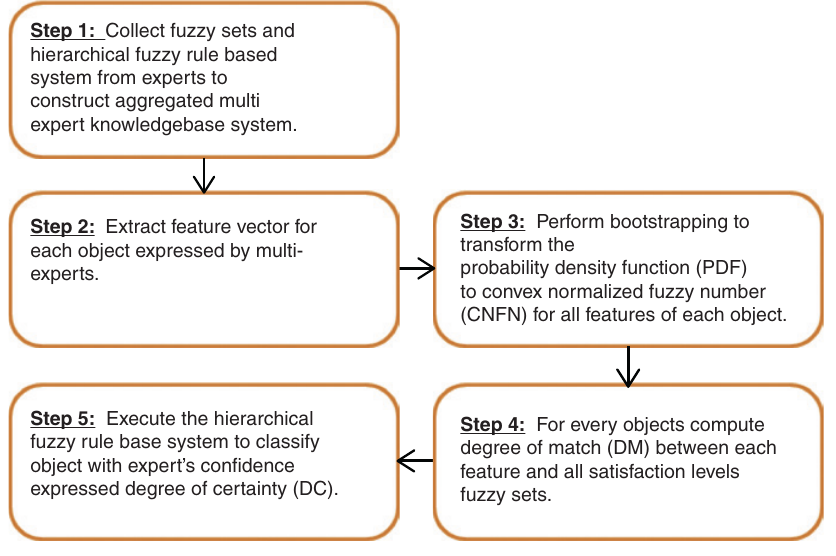
Figure 4: ZD Formalism